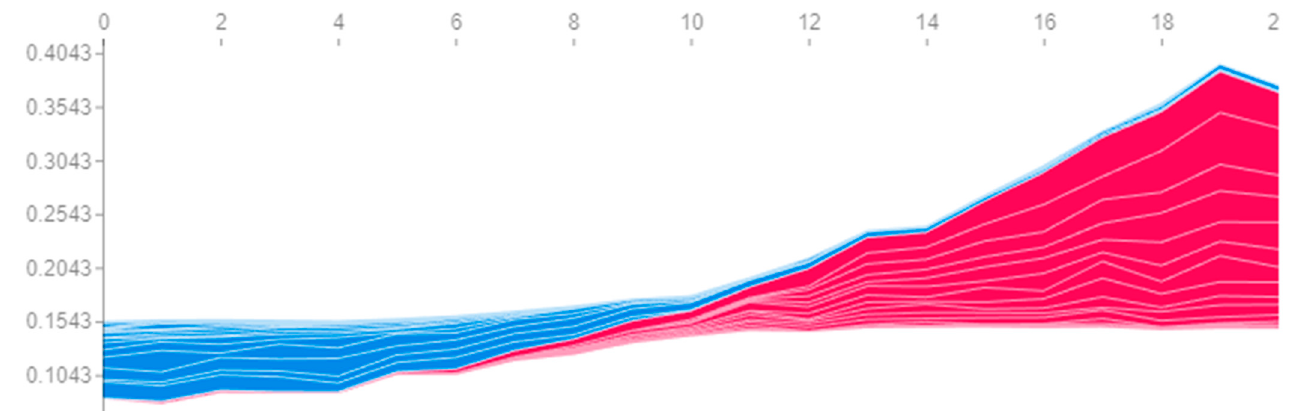
Figure 12. Contribution of features to the probability of failure of engine #81 on time windows.